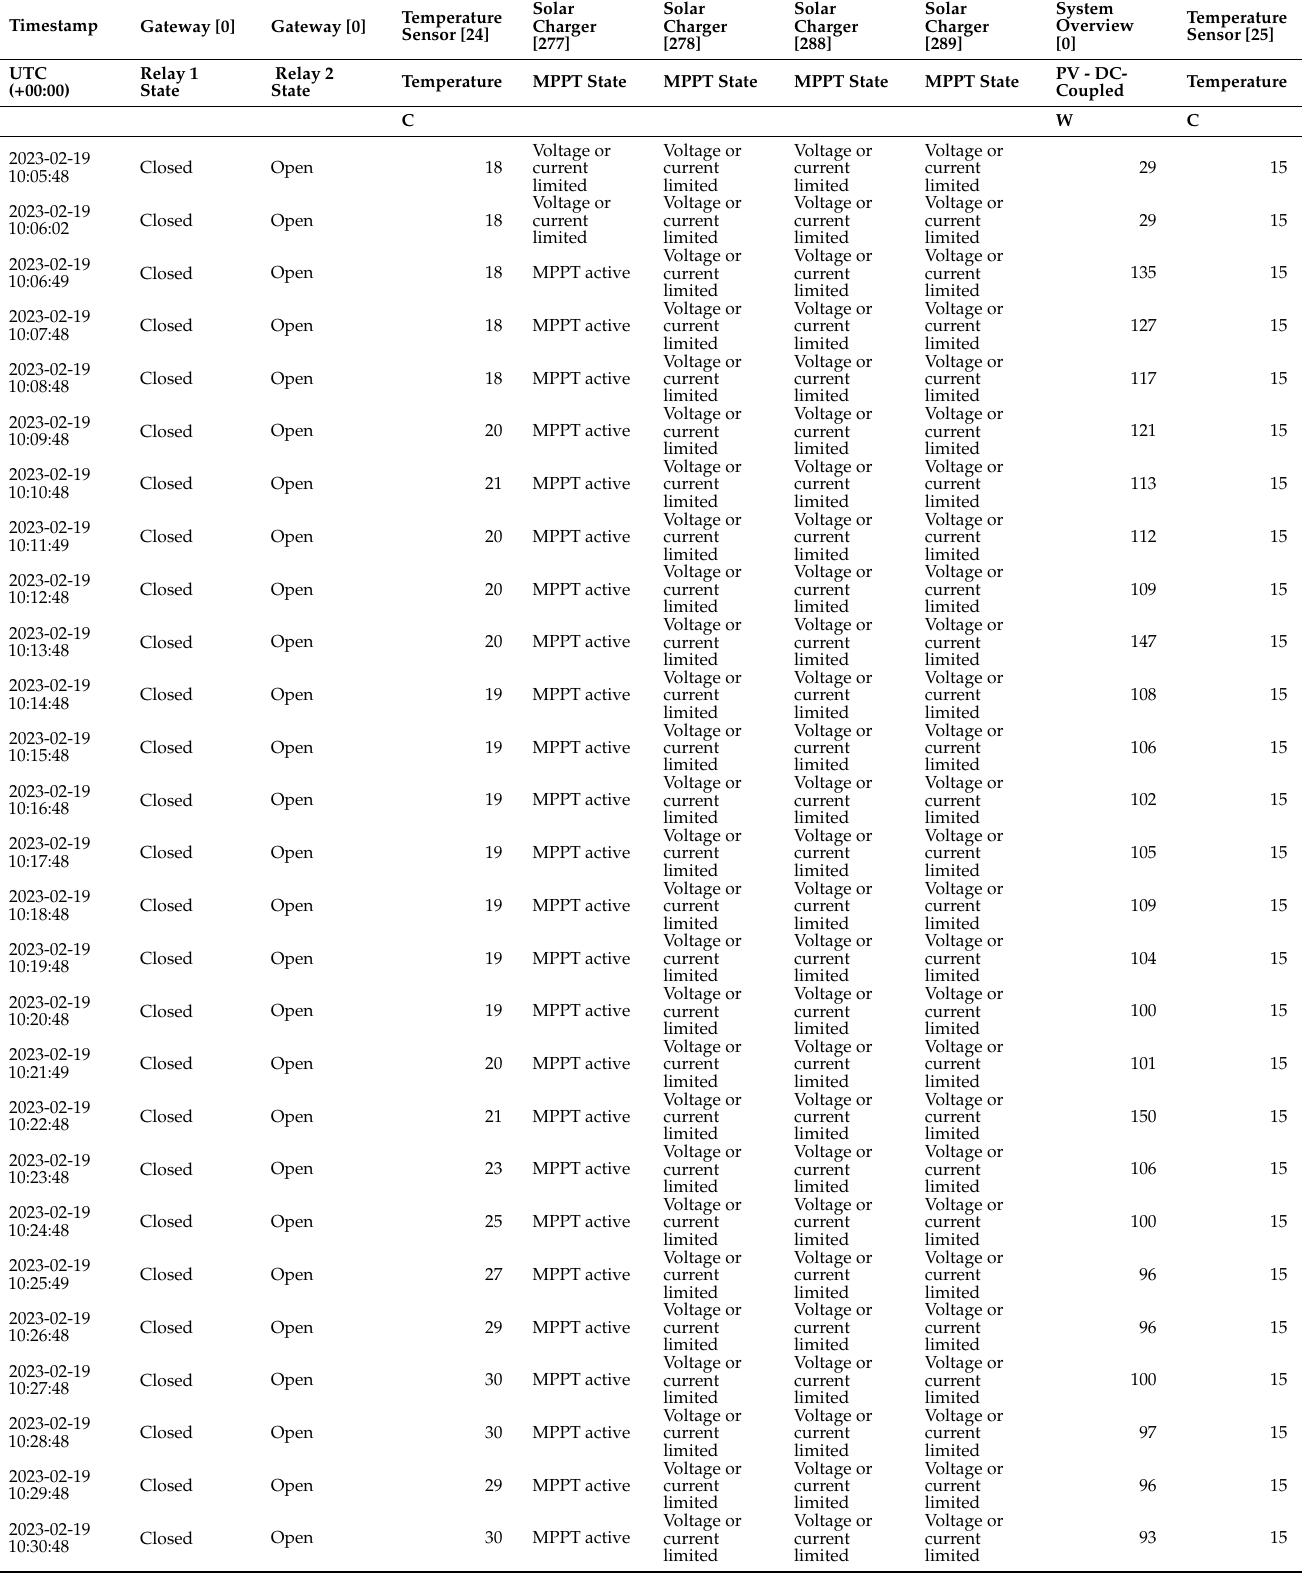
Table 5. Capture in test based on high-temperature alarms in the battery using Temperature Sensor 24 acting on Relay